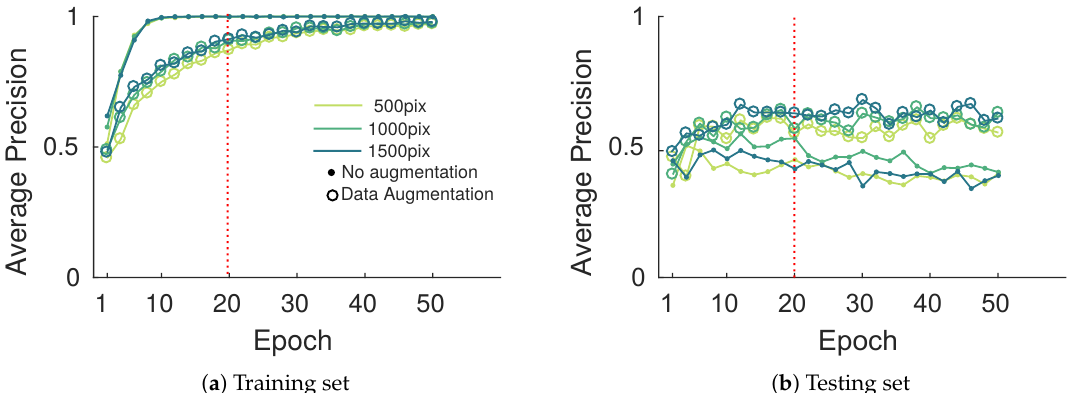
Figure 15. Evolution of the esca average precision metric on the training and testing set with the epoch during the training process.